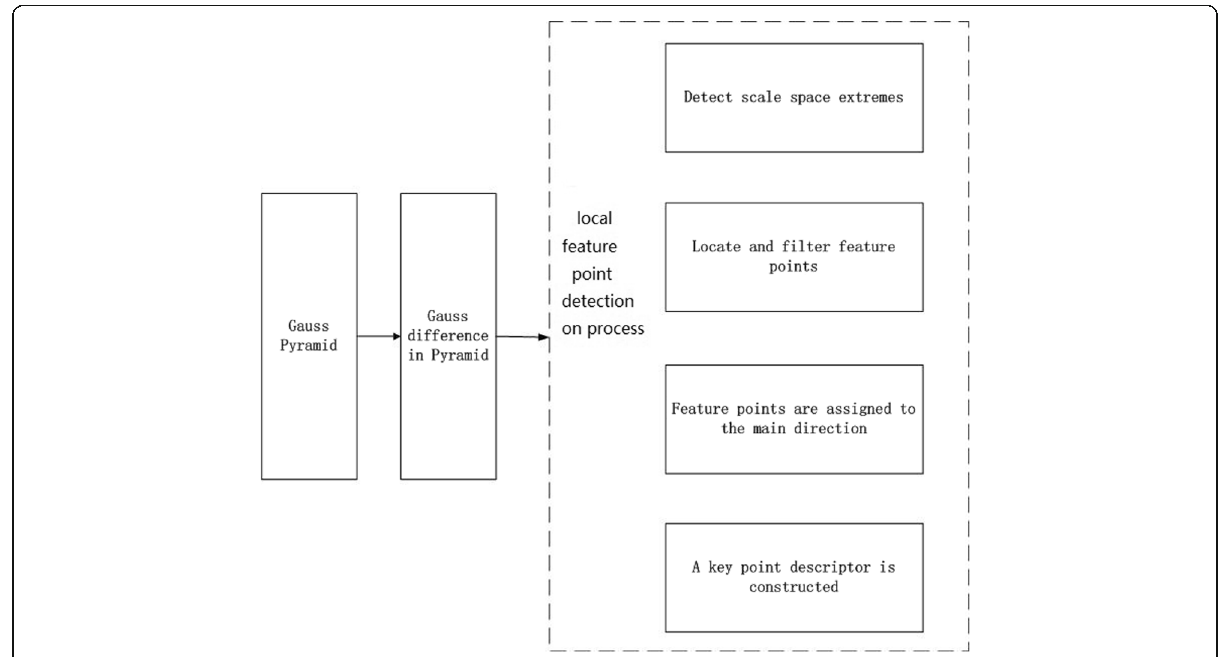
Fig. 1 Feature point detection process based on SIFT